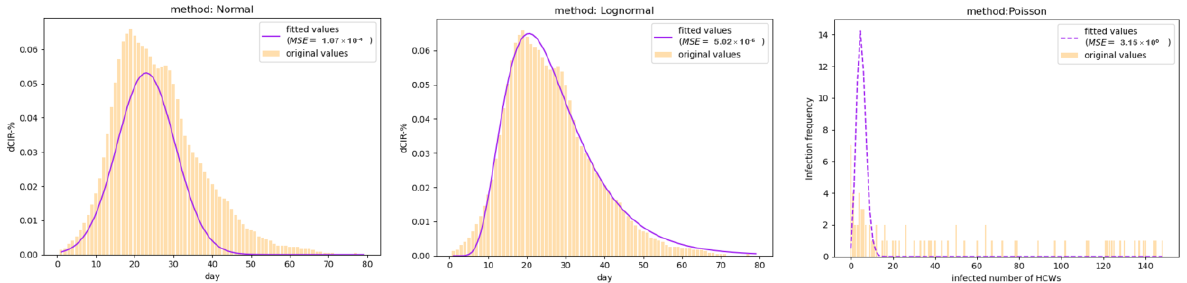
Figure 3. The time-fitting distribution of the infection rate/num of HCWs in Hubei Province.